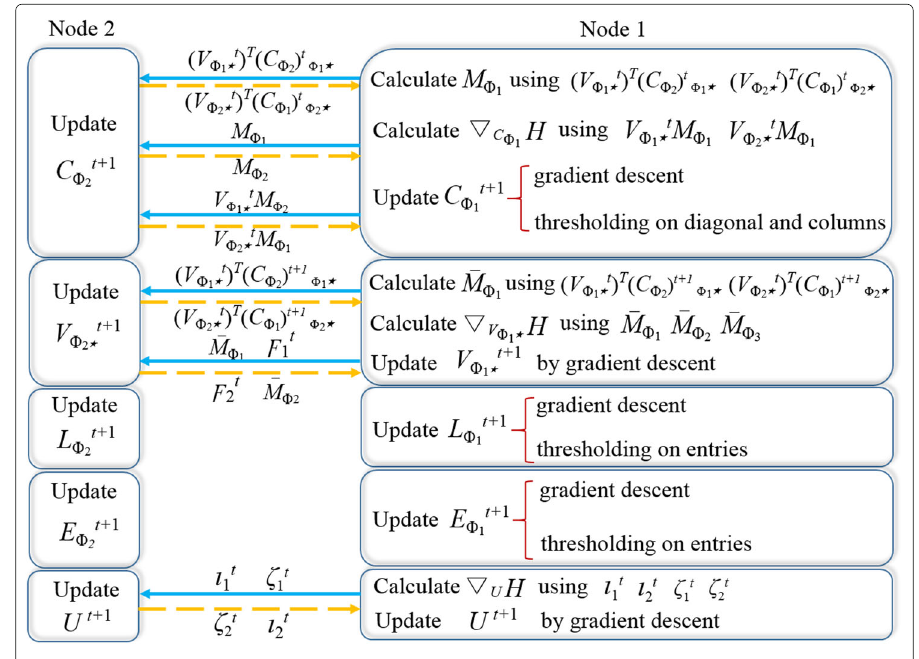
Fig. 3 Computation and communication in DSAPA ( W =